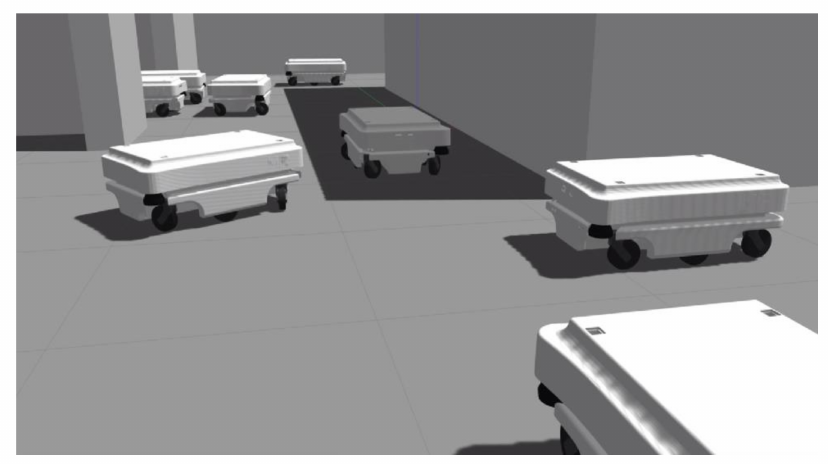
Figure 5. Physics-based simulation developed using Robot Operating System (ROS) and Gazebo